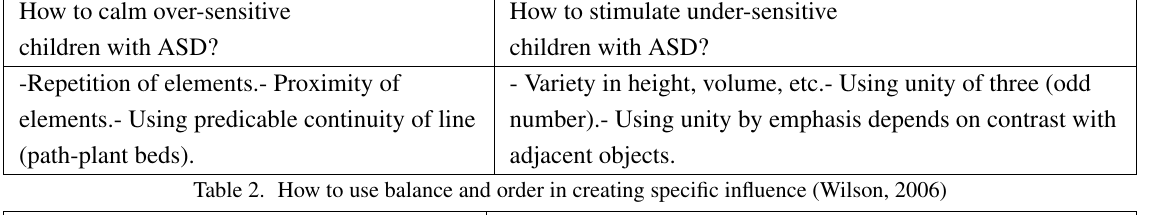
Table 2. How to use balance and order in creating specific influence (Wilson, 2006)